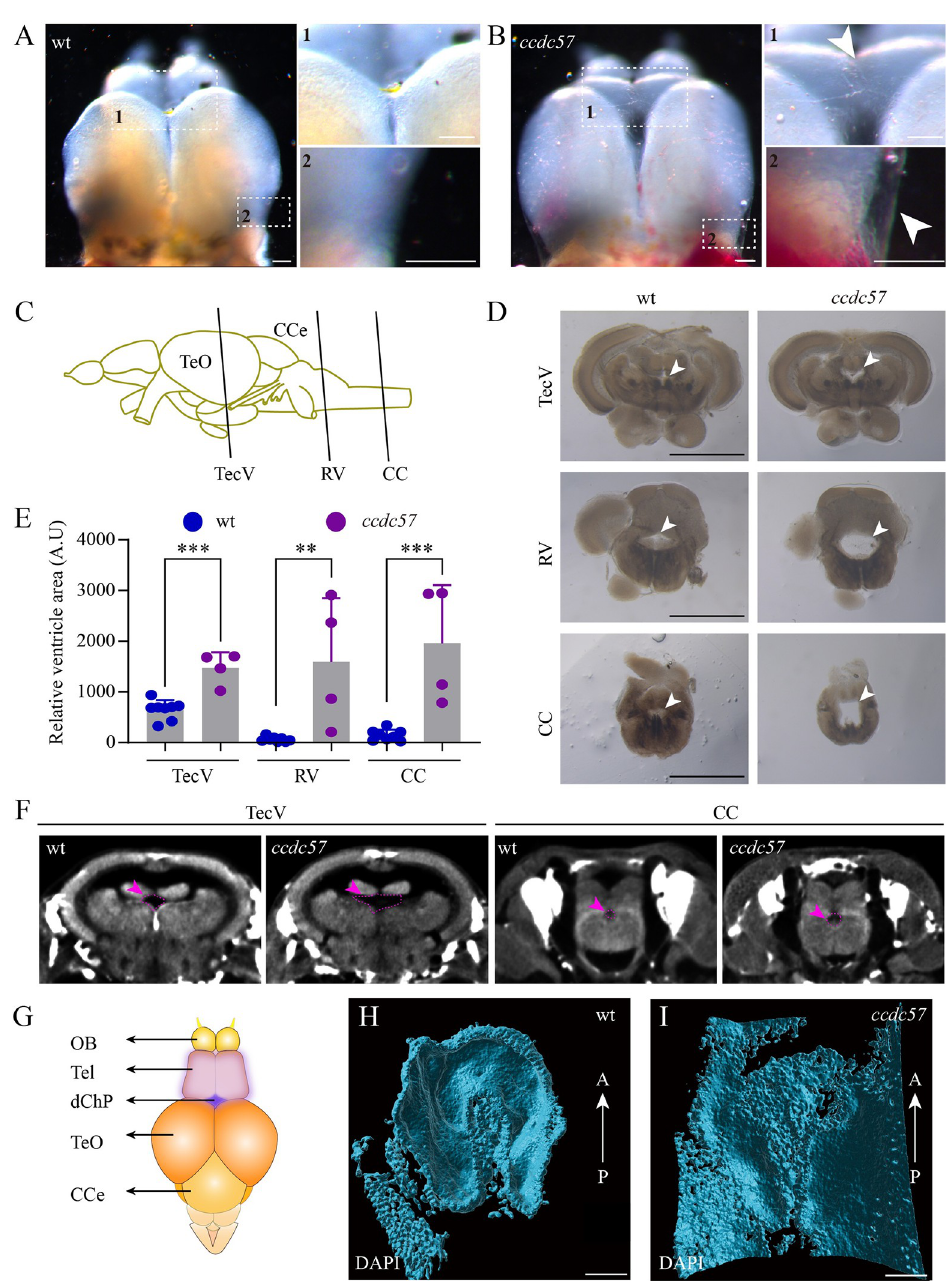
Fig 2. Hydrocephalus in ccdc57 mutants. ( A , B ) External phenotypes of telencephalons in wild type and ccdc57 mutant. Arrows point to the expanded ependymal epithelia due to excess CSF accumulation. ( C ) Diagram of the brain tissue in zebrafish showing the sites of crossing section in different ventricles. CCe, corpus cerebelli; TeO, tectum opticum; CC, central canal; TecV, tectal ventricle; RV, rhombencephalic ventricle. ( D ) Histological cross-sections showing ventricles (arrows) at different sites as indicated. ( E ) Bar graph showing relative size of brain ventricles at different sites as indicated. ( F ) Micro-CT images showing the ventricles (arrows) in TecV and CC of wild type and mutant. ( G ) Diagram showing the position of diencephalic choroid plexus (dChP) in adult zebrafish. OB, olfactory bulb; Tel, telencephalon. ( H , I ) Three-dimensional reconstruction of dChP visualized with DAPI staining in wild type and ccdc57 mutant. These still images are from S1 Movie and visualized from ventral side of the dChP. A, anterior; P, posterior. Scale bars: 100 μ m in panels A and B, 1 mm in panel D, and 50 μ m in panels H and I. The data underlying the graphs shown in the figure can be found in S1